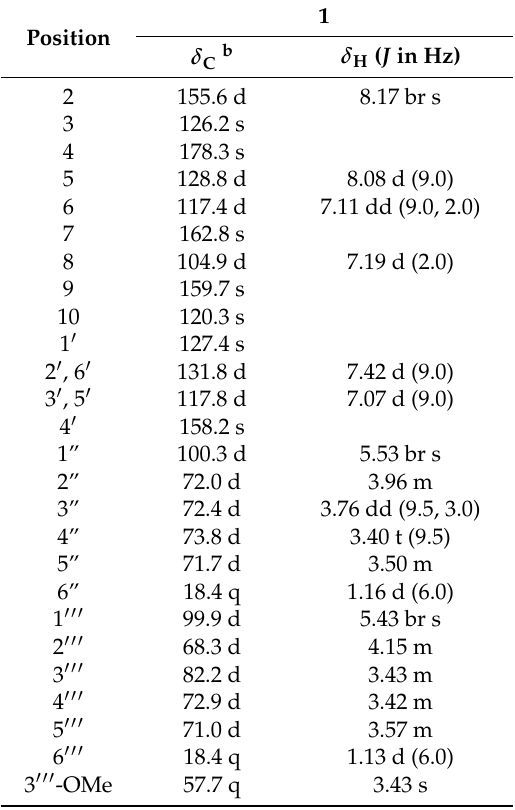
Table 1. 1 H (800 MHz) and 13 C (200 MHz) NMR data of 1 in CD 3 OD. a